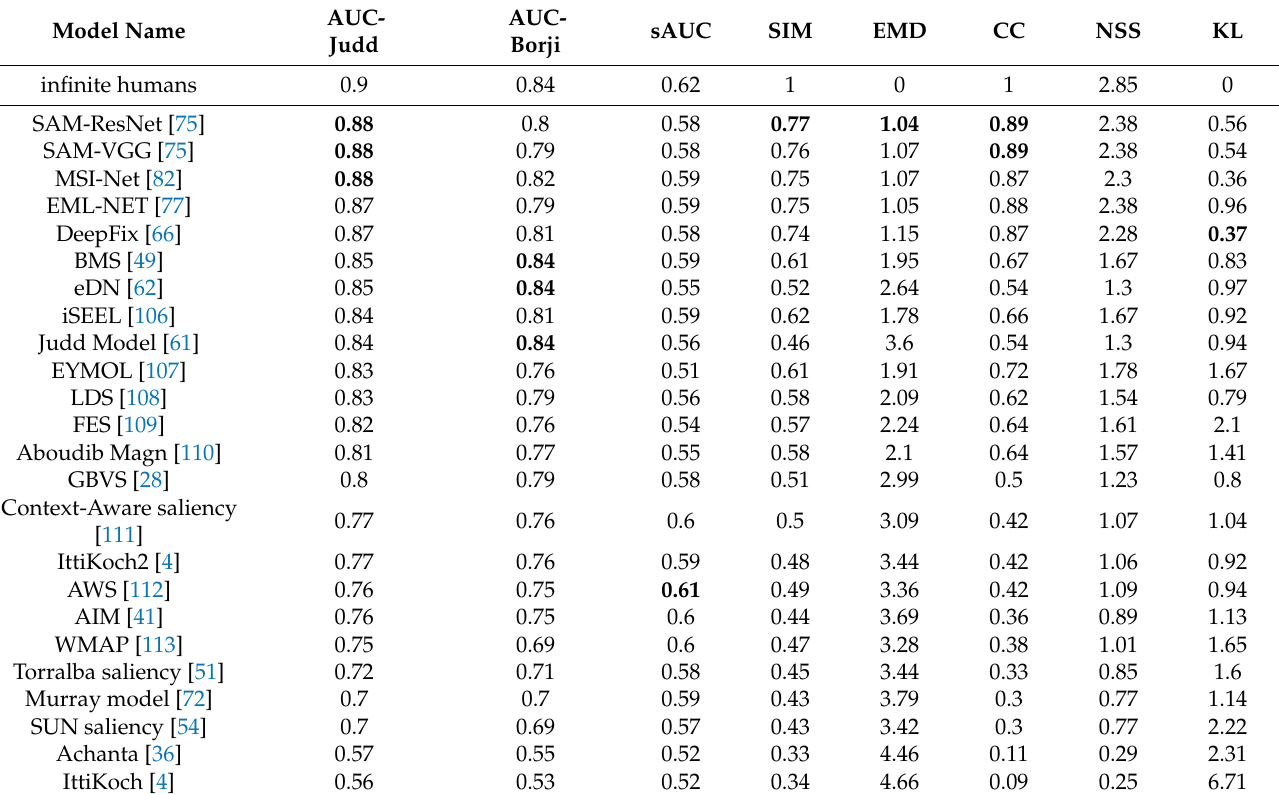
Table 3. Performance of the static models over the CAT2000